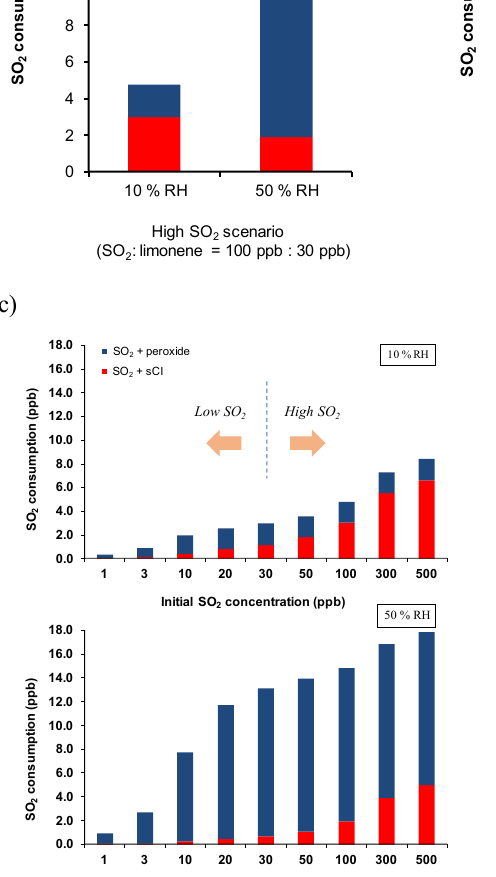
sulfate on SOA yields, which likely promotes both function- alization and oligomerization reactions. Here we show that while SO 2 leads to a decrease in oligomerization, but there is still an overall increase in SOA yields from limonene ozonol-